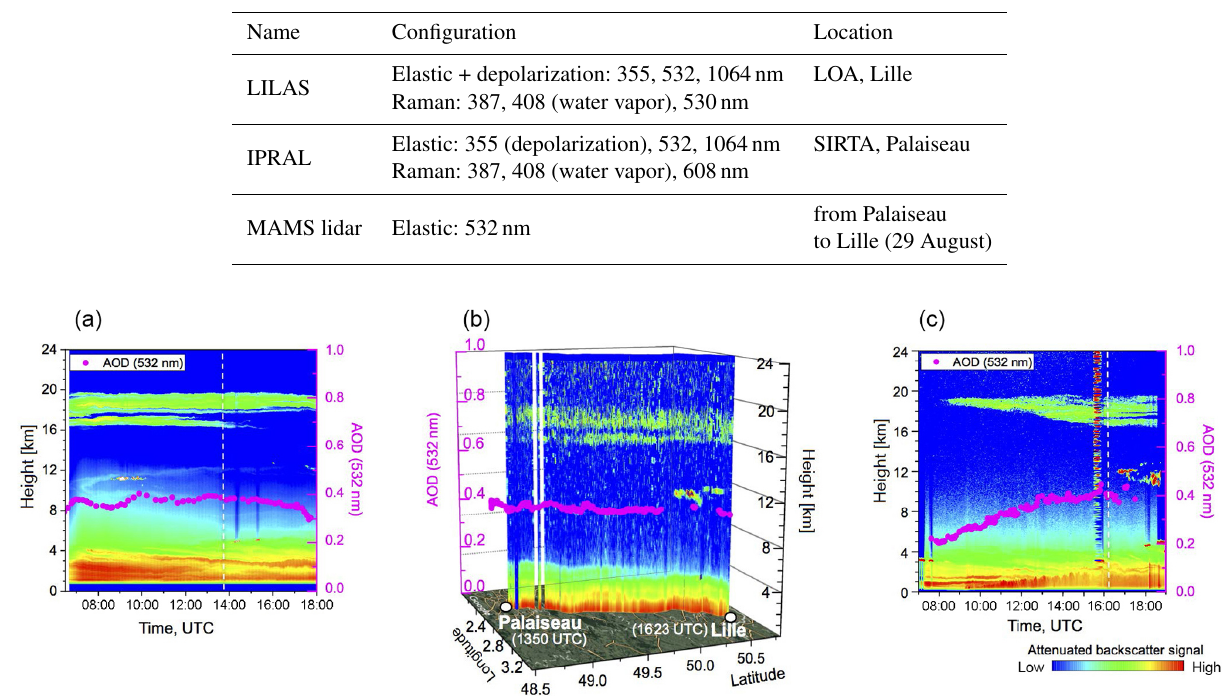
Figure 1. Lidar range-corrected signal and columnar AOD from the sun photometer at 532nm on 29 August 2017. (a) IPRAL system in Palaiseau. (b) MAMS lidar en route from Palaiseau to Lille. (c) LILAS in Lille. Columnar AOD measurements are interpolated from AERONET (Lille and Palaiseau) and PLASMA (mobile system) measurements. MAMS started from Palaiseau at 13:53UTC and arrived in Lille at 16:23UTC. The departure and arriving times are indicated in (a) and (c) with the dashed white lines.